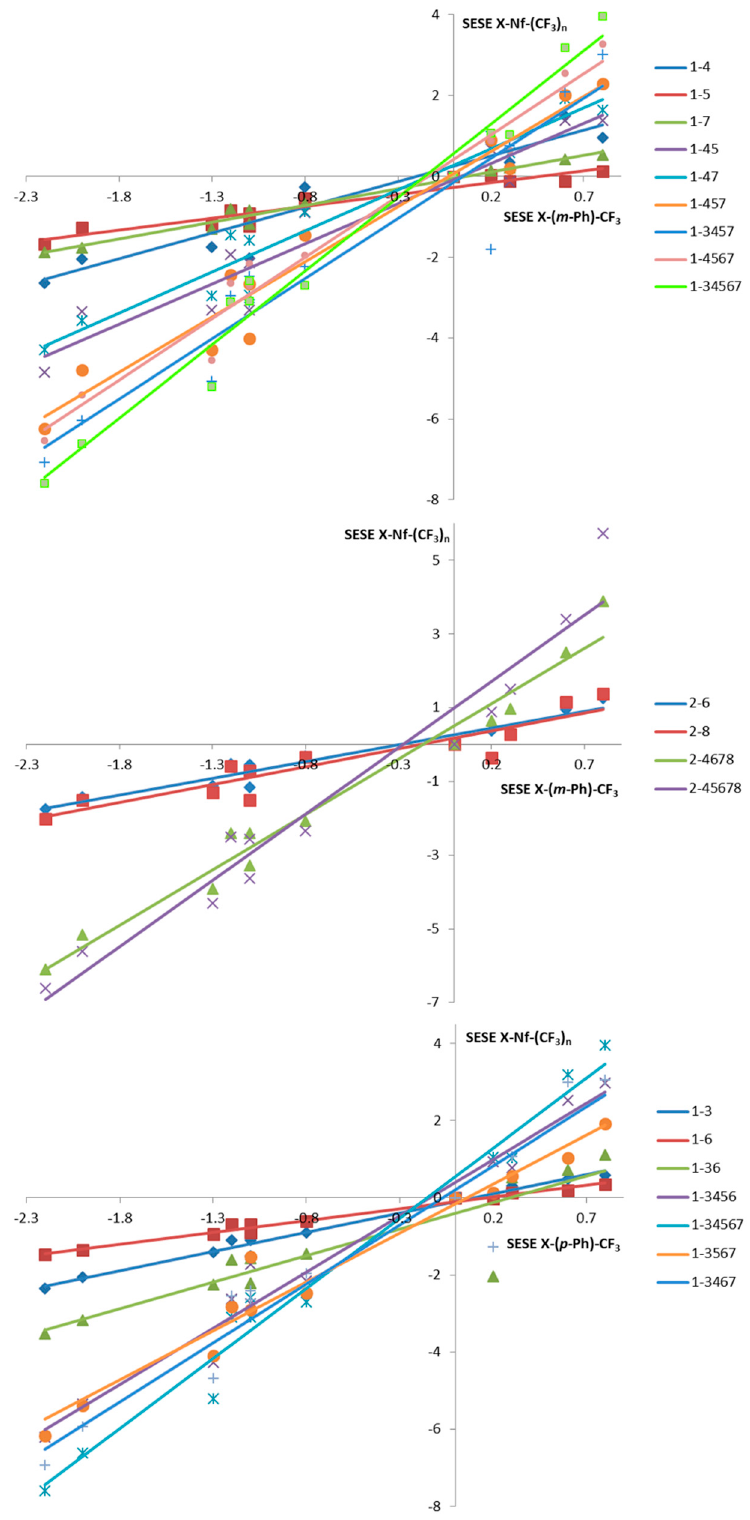
Figure 8. Comparison of dependences of SESE values of analyzed probes on SESE values of m ‐ substituted benzene derivatives X ‐ ( m ‐ Ph) ‐ CF 3 for selected types of naphthalene derivatives.